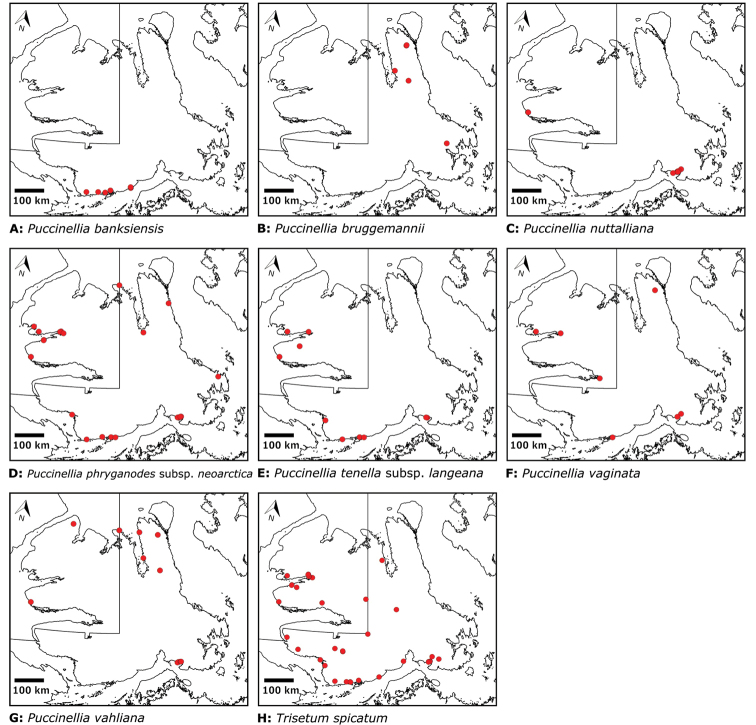
Species distribution maps. Poaceae: APuccinellia
banksiensisBPuccinellia
bruggemanniiCPuccinellia
nuttallianaDPuccinellia
phryganodes
subsp.
neoarcticaEPuccinellia
tenella
subsp.
langeanaFPuccinellia
vaginataGPuccinellia
vahlianaHTrisetum
spicatum.